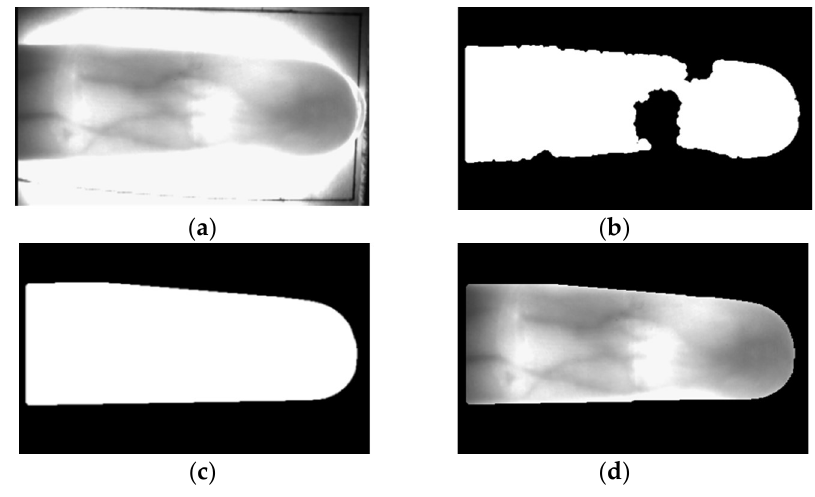
Figure 2. Examples of input image and detected finger region: ( a ) original input image; ( b ) incorrect binarized image; ( c ) corrected binarized image by component labeling and convex hull processing; and, ( d ) detected finger region.